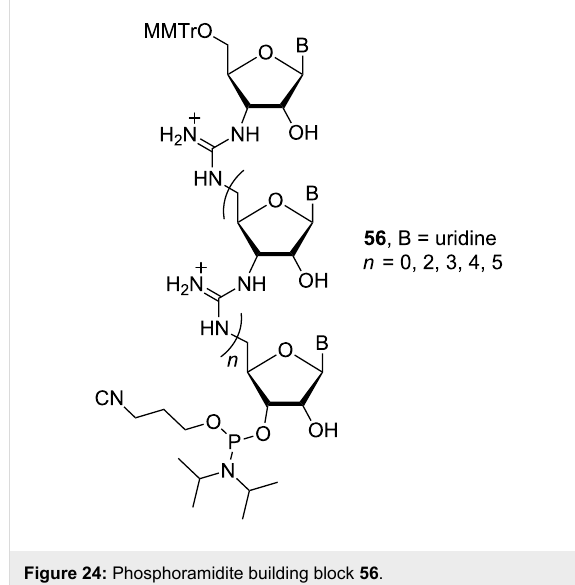
Figure 24: Phosphoramidite building block 56